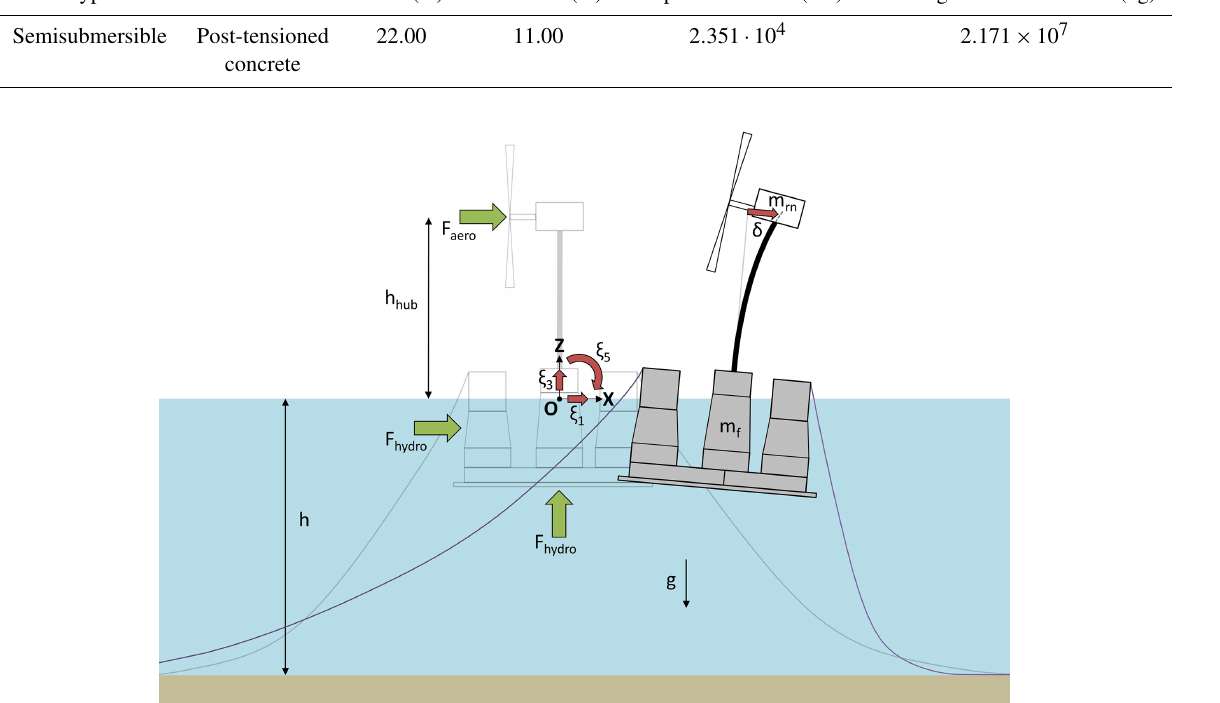
Figure 1. Sketch of the floating wind turbine as seen by the QuLAF model from Pegalajar-Jurado et al. (2018a).